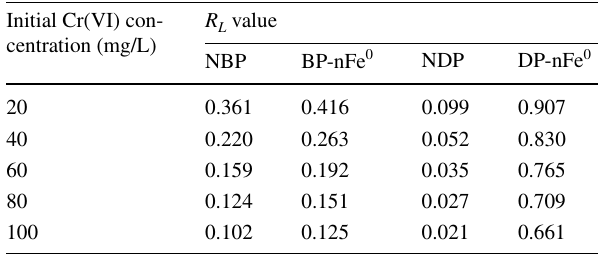
Table 2 Langmuir separation factor for NBP, BP-nFe 0 , NDP, DP- nFe 0 Initial Cr(VI) con- centration